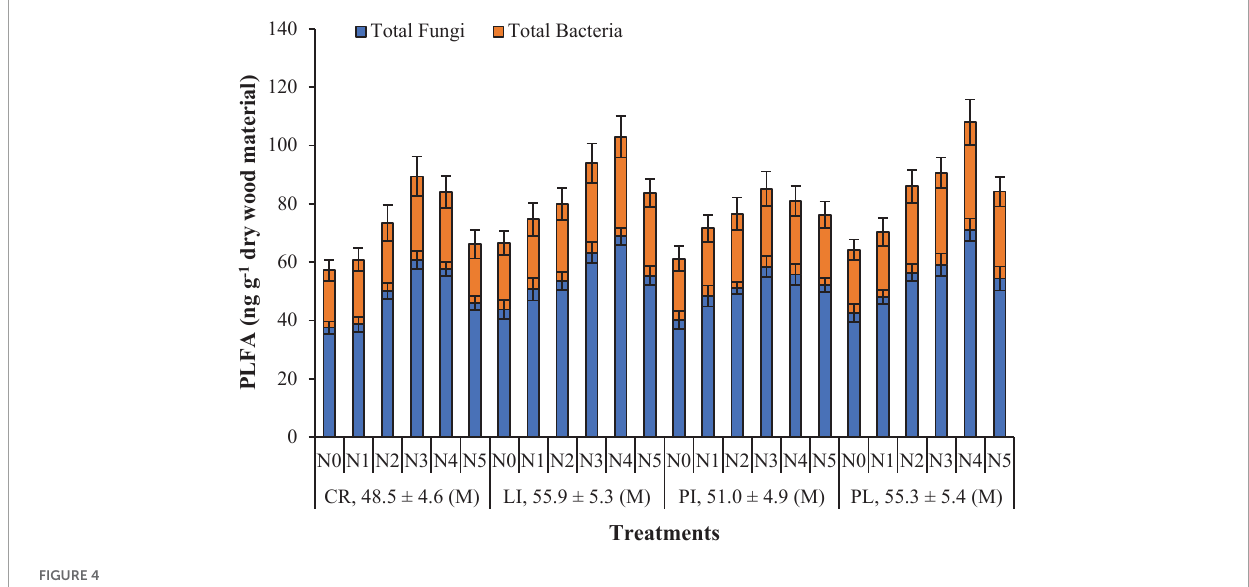
FIGURE4 The phospholipid fatty acid (PLFA) (mean ± SE; ng g - 1 dry wood material) signatures of the four studied species under the different N fertilization treatments. Error bars indicate the standard error ( n = 6). N5, IN:ON = 0:10; N4, IN:ON = 3:7; N3, IN:ON = 5:5; N2, IN:ON = 7:3; N1, IN:ON = 10:0 and N0, control. Cryptomeria japonica ( CR ), Platycarya strobilacea ( PL ), Pinus taiwanensis ( PI ) and Lithocarpus glaber ( LI ). M: mean value of different N fertilization treatments and the data including mean ±